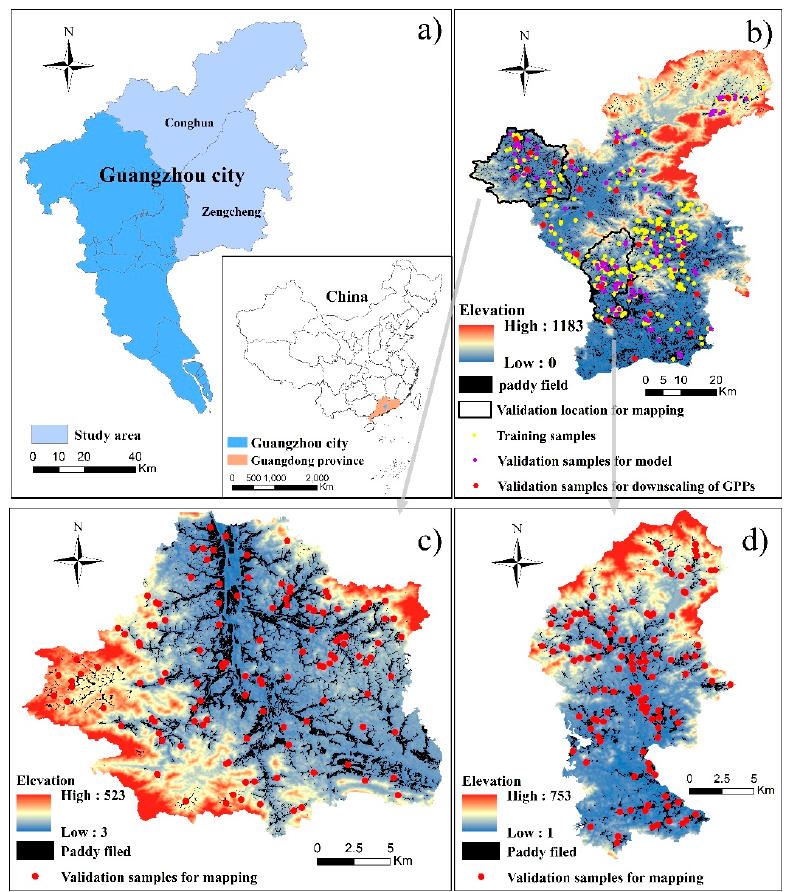
Figure 1. The study area location in Guangzhou City ( a ), and Conghua and Zengcheng District ( b ), respectively, with a total of 420 sample plots for cultivated land quality (CLQ) (training sample plots are in yellow and validation sample plots for the model in purple) and another set of 240 sample plots in red for validating multi-scale Moderate-resolution Imaging Spectroradiometer (MODIS) gross primary production (GPP) products; ( c , d ) the validation areas for mapping at Aotou Town of Conghua District and Zhongxin Town of Zengcheng District.